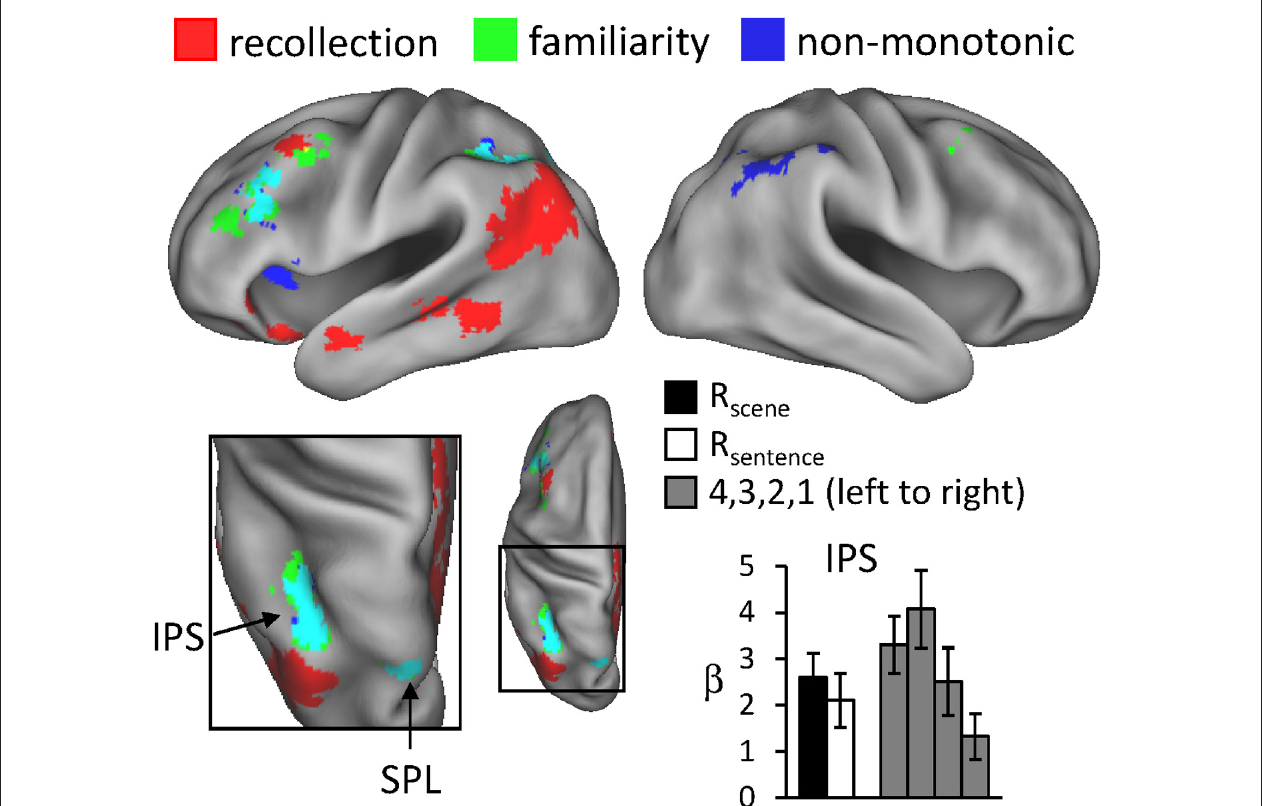
FIGURE 4 | Regions exhibiting non-monotonic effects (blue), as identified by greater activity for 4 compared to R and 1 judgments (see text for details), across the test-phase judgments. The neural correlates of recollection (red) and familiarity (green) from previous figures are also